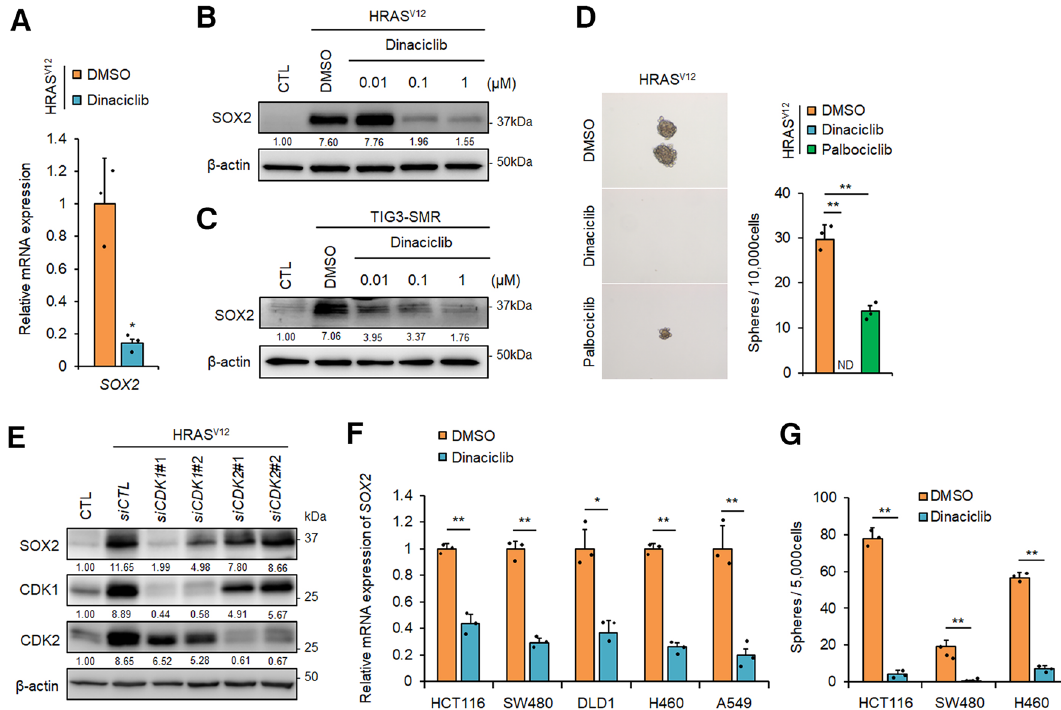
Figure 4. CDK1 activity is required for SOX2 induction and generation of CSCs in RAS- activated cells. ( A ) qPCR analysis of SOX2 mRNA levels in HRAS V12 -expressing p53 −/− MEFs treated with vehicle (DMSO) or dinaciclib (0.1 µM) for 24 h. * P < 0.05. ( B ) and ( C ) Western blot analysis of SOX2 expression in HRAS V12 - expressing p53 −/− MEFs ( B ) and TIG-3–SMR cells ( C ) treated with vehicle or dinaciclib (0.01, 0.1, 1 µM) for 24 h. ( D ) Sphere formation of HRAS V12 -expressing p53 −/− MEFs after 7 days in the presence or absence of dinaciclib (0.1 µM) or palbociclib (10 µM). Representative images are shown on the left, and quantification is shown on the right. ND, not detected. ** P < 0.01. ( E ) Expression levels of SOX2 in HRAS V12 -expressing p53 −/− MEFs following knockdown of CDK1 or CDK2 by siRNAs. ( F ) qPCR analysis of SOX2 mRNA expression in HCT116, SW480, DLD1, H460, and A549 cancer cell lines treated with dinaciclib (0.1 µM) for 24 h. * P < 0.05, ** P < 0.01. ( G ) Sphere formation assay of cancer cells in the presence or absence of dinaciclib (0.1 µM) for 7 days. ** P < 0.01. ( A ), ( D ), ( F ), and ( G ): Data are presented as the means ± SD of three independent experiments. Statistical analysis was performed with Student’s t-tests. ( B ), ( C ), and ( E ): The band intensity is provided under each band. Uncropped blot images are presented in Supplementary Fig.